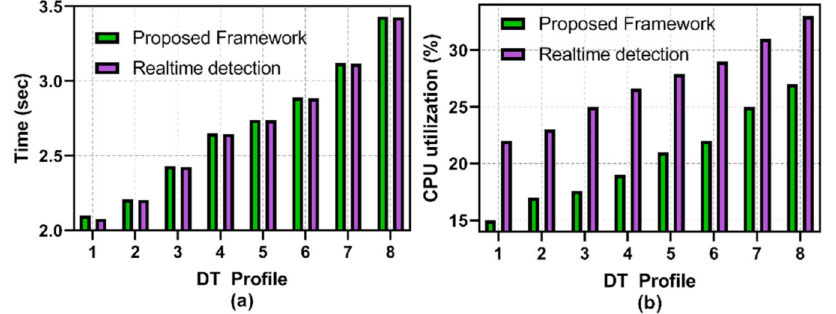
Figure 5. ( a ) PA packet analysis; ( b ) CPU utilization of